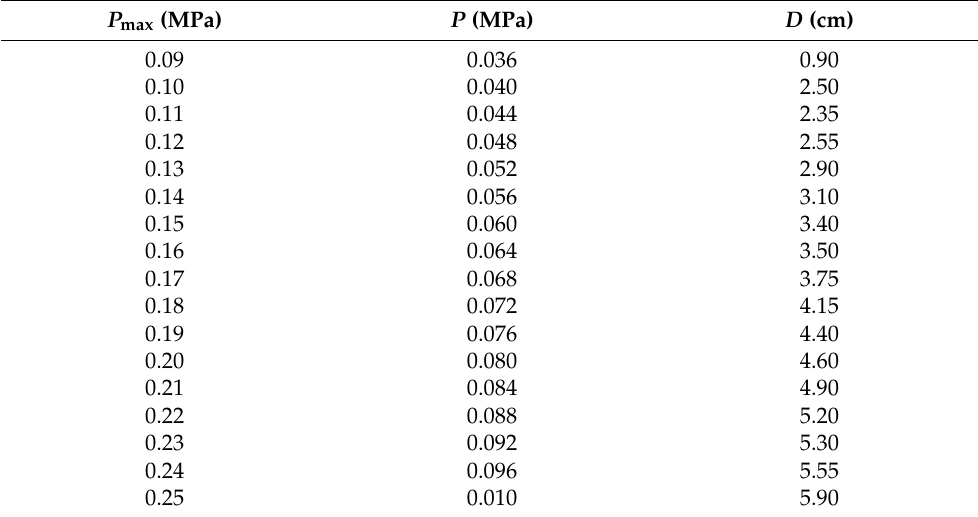
Table 1. Position training results of the